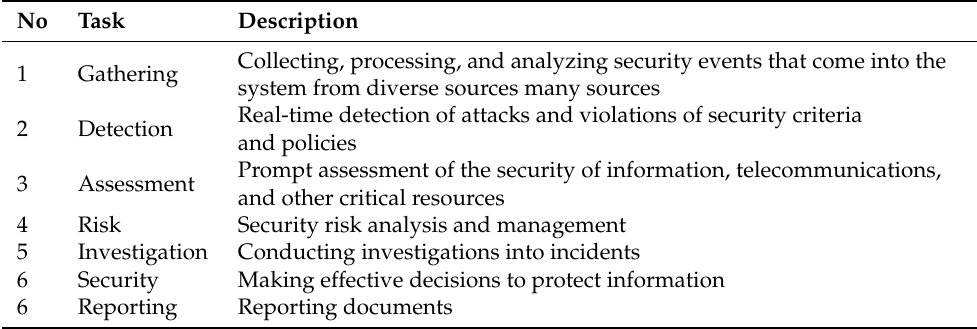
Table 1. Tasks mainly accomplished by a SIEM